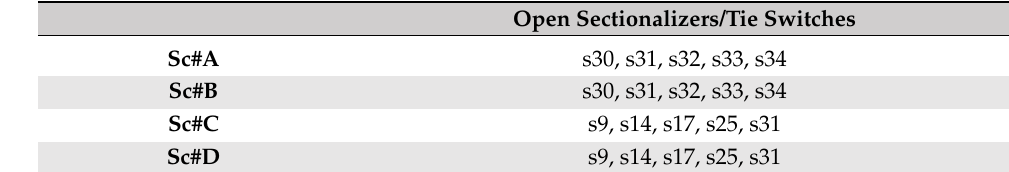
Table 6. Open sectionalizers/tie switches.